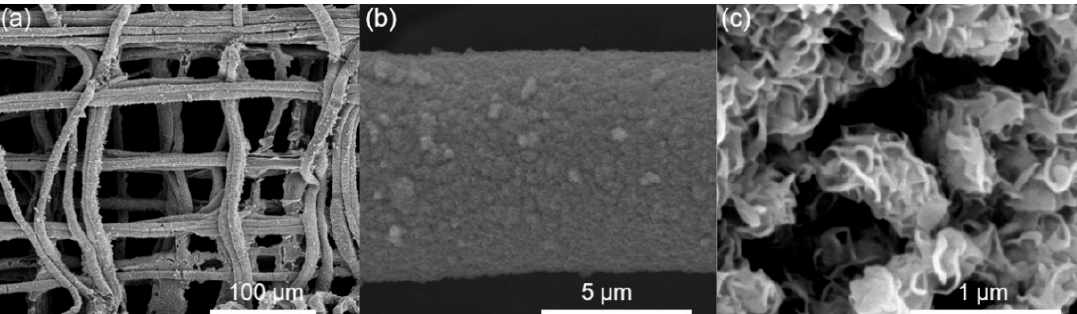
Figure 4. The micro/nanoscale morphology of the MoS 2 -PVDF composite film. ( a ) The microscopic images of the MoS 2 -coated PVDF fibrous film. ( b ) The microscale characterization of the MoS 2 coated PVDF fiber. ( c ) The SEM image of the MoS 2 nanostructures.